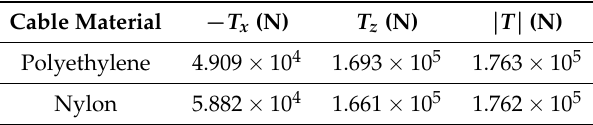
Figure 19. Time evolution of the tension force on the cable at the fairlead for two different cable materials. Table 2. Results at equilibrium of the tension on the boat’s end of the cable for submerged body towing systems with different cable